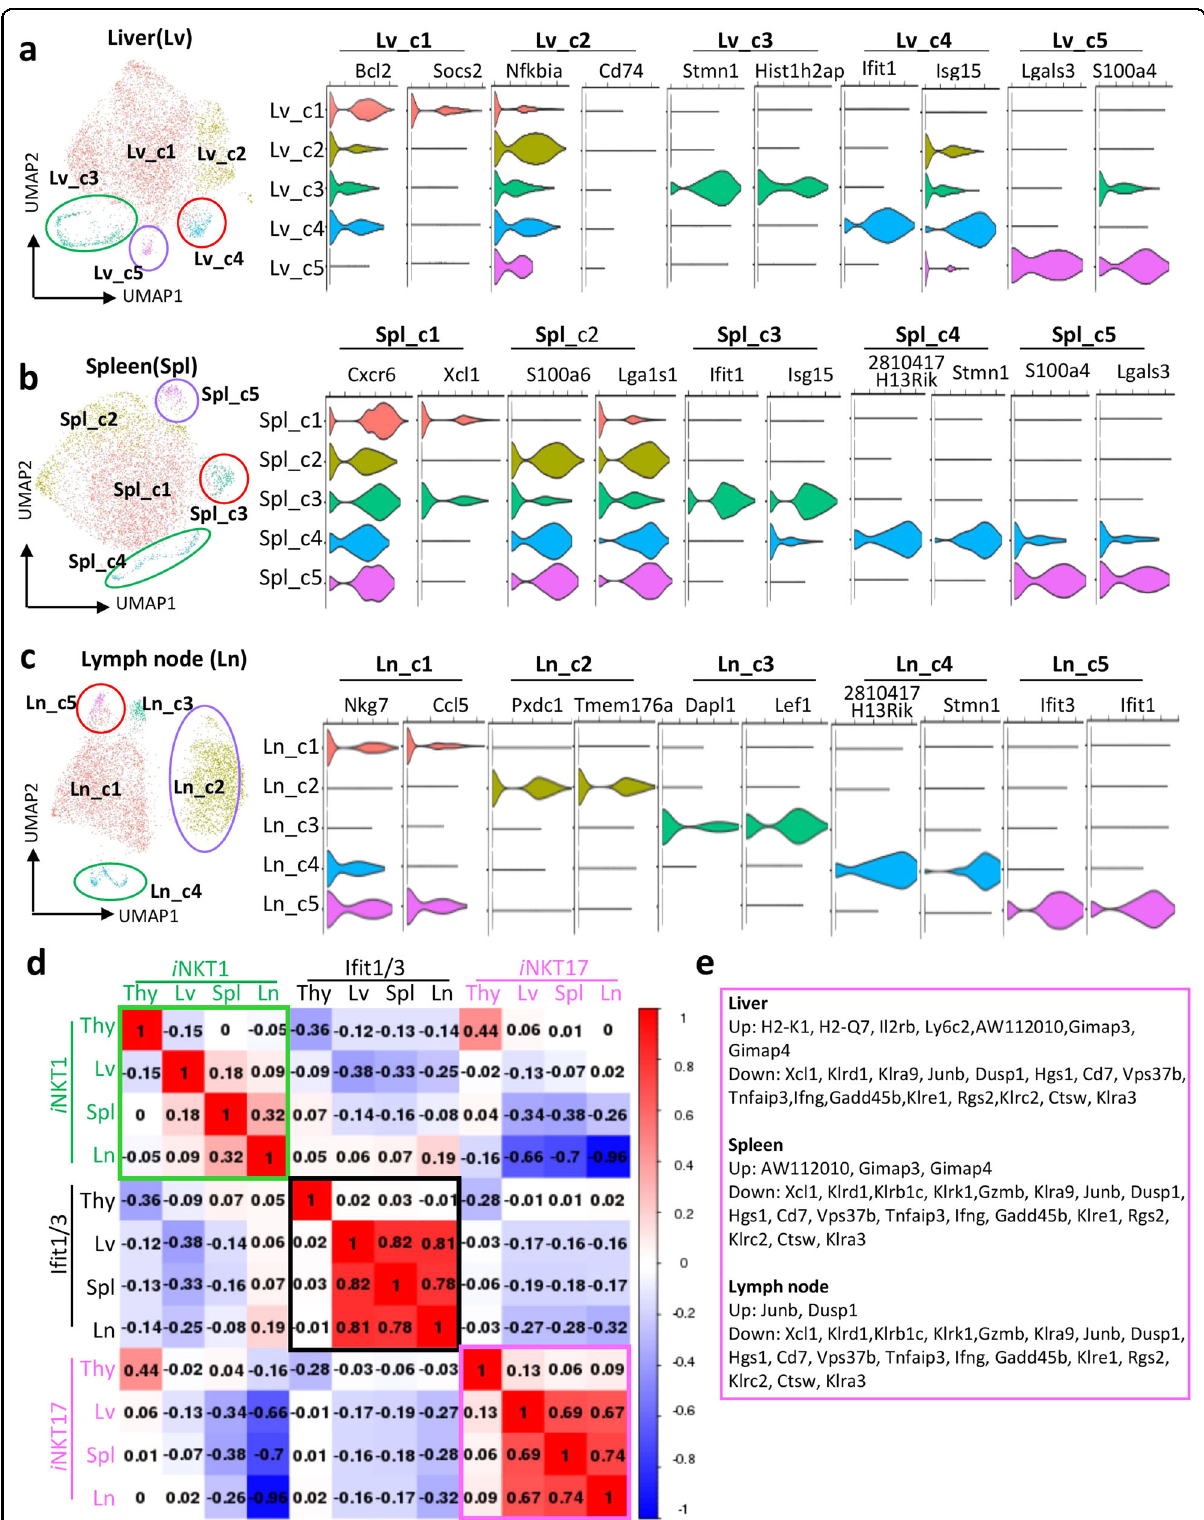
Fig. 3 Comparison of transcriptomic pro fi les among i NKT cells from different peripheral organs. a – c UMAP plots from 10X genomics scRNA- Seq dataset from sorted liver i NKT cell(a), spleen i NKT cell ( b ), and Lymph node i NKT cells ( c ) (left). Violin plots showing the top two cluster-speci fi c signatures in i NKT cells from liver ( a ), spleen ( b ), and lymph node ( c ). d Pearson correlation matrix of the average expression pro fi les based upon all differentially expressed genes from all indicated subpopulations analyzed. e Gene list showing signi fi cant change of i NKT1 signatures among i NKT cells from thymus, liver, spleen, and lymph node, extracted from ( d